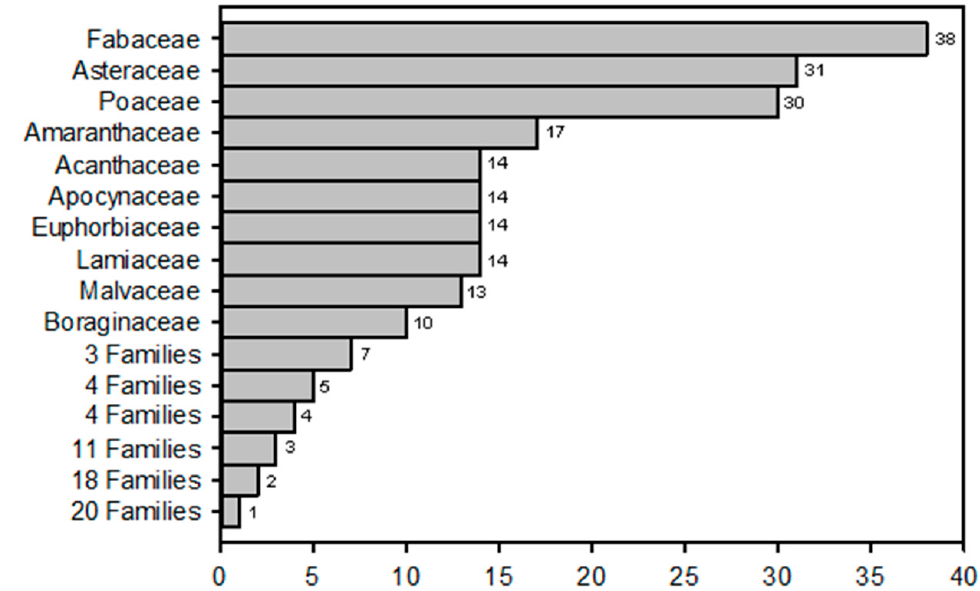
Figure 3. Histogram of the floristic composition of the 70 families surveyed in Jabal Fayfa.